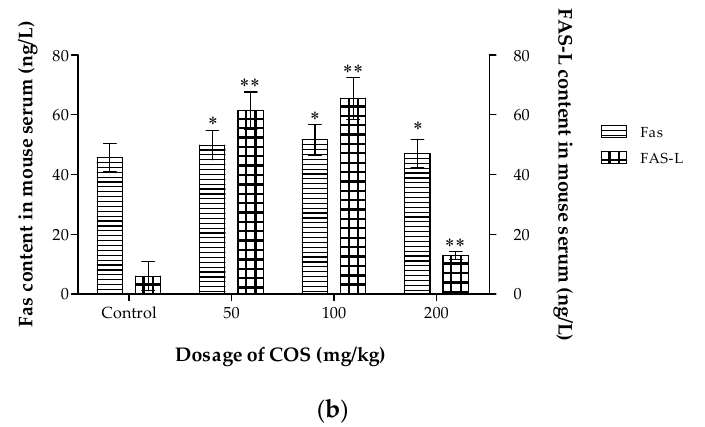
Figure 7. Effect of COS on serum TNF-α, IL-2 ( a ), and Fas, Fas-L ( b ) levels. Data represents mean ± SD, n = 12, * p < 0.05, ** p < 0.01 significant difference compared with control group.